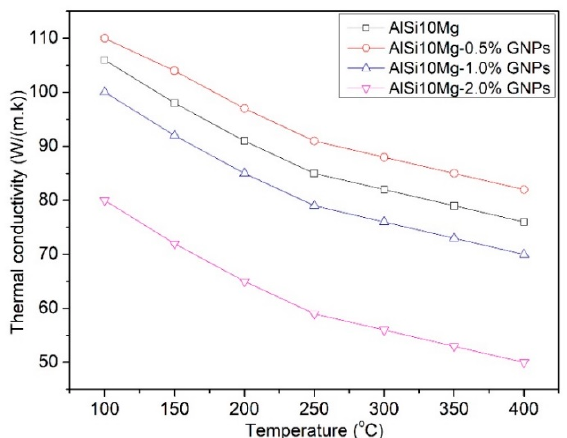
Figure 9. Thermal conductivity of AlSi10Mg– x wt.% GNPs ( x = 0, 0.5, 1.0 and 2) after hot consolidation.